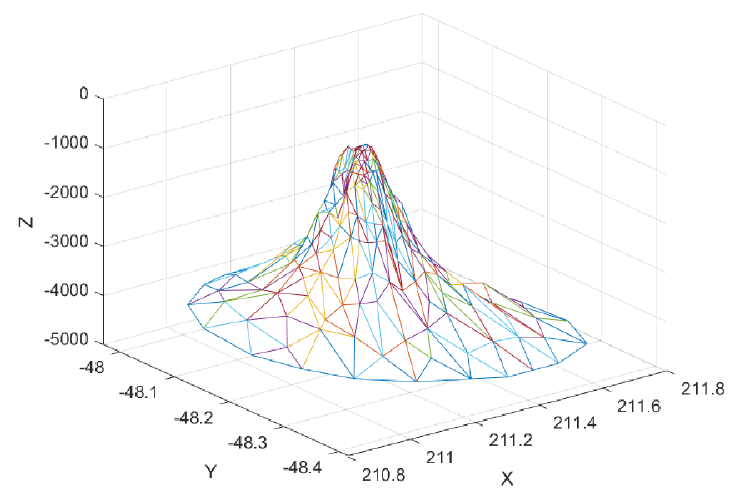
Figure 26. 3D visualization of seamount dataset.